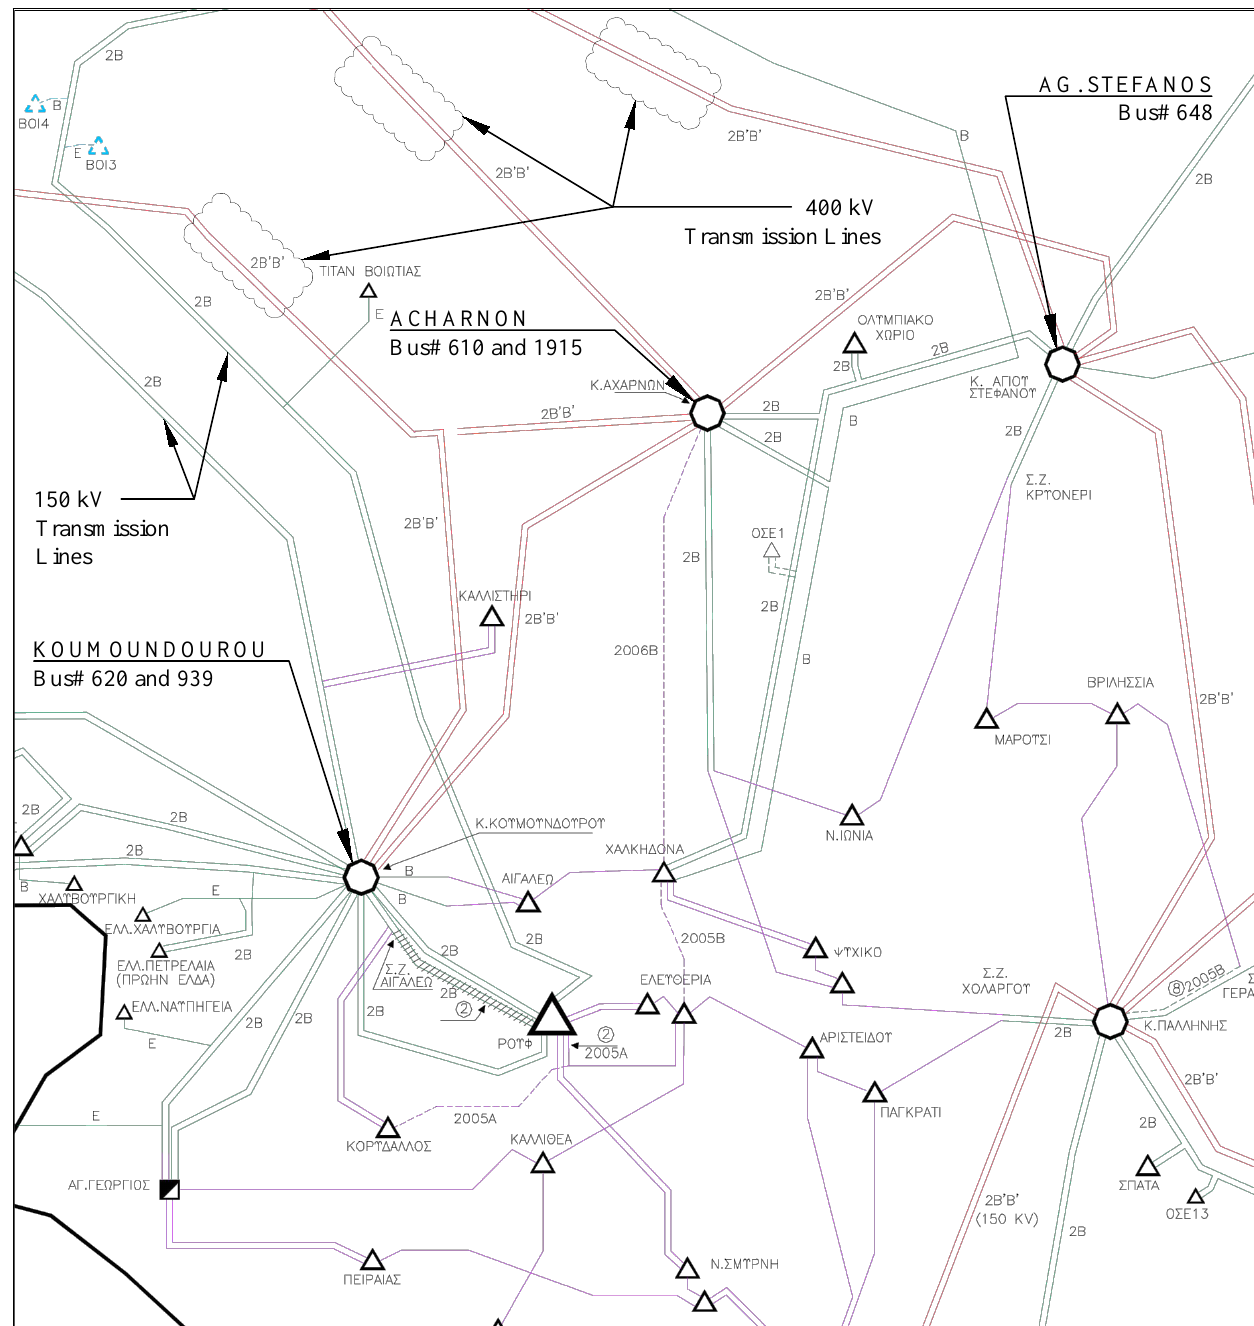
Figure 3. The 400kV boundary buses and respective corridor lines at the area of Attica, Hellenic Interconnected System